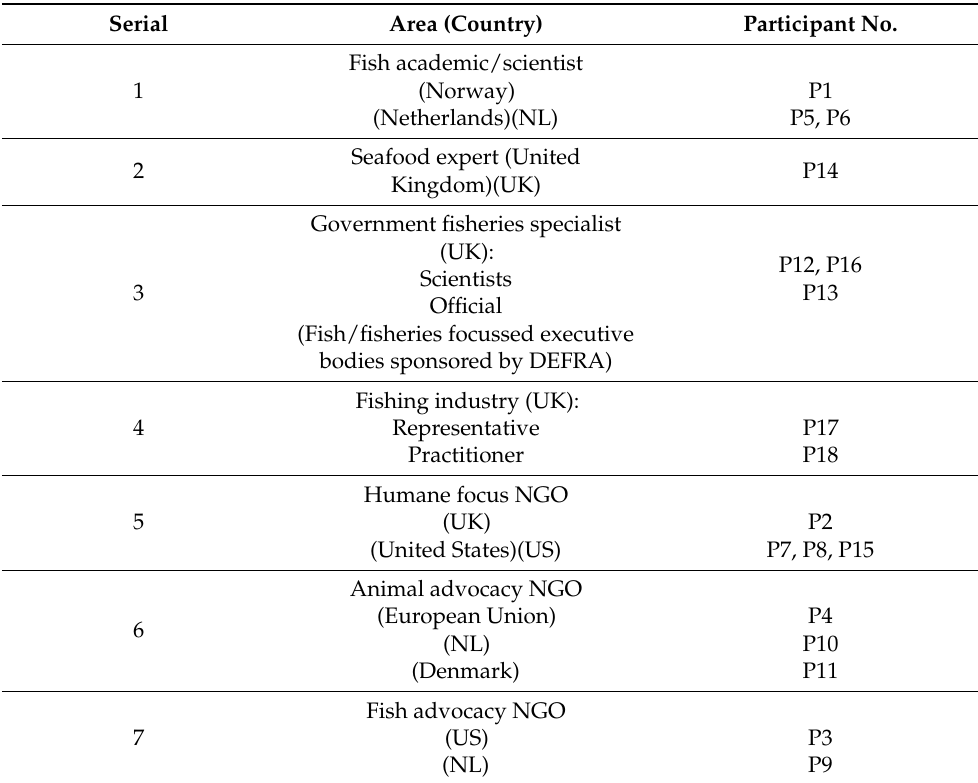
Table 2. Interviewee decode by specialist